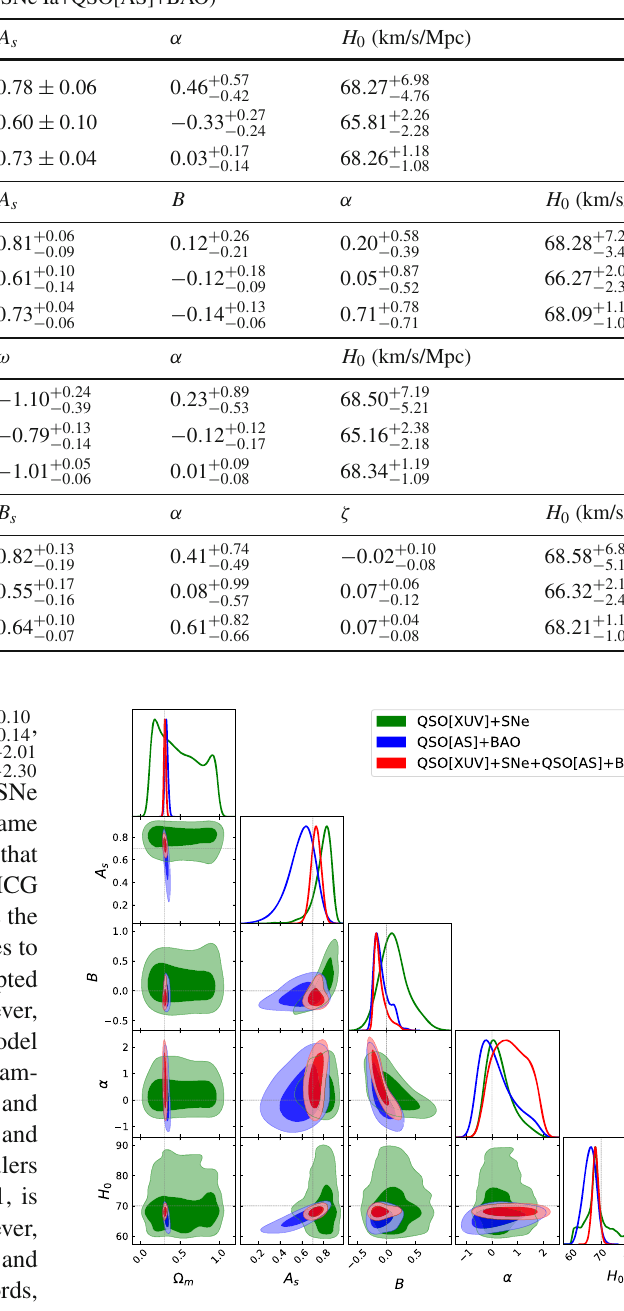
Fig. 3 The 1D and 2D probability distributions of model parameters in the MCG model